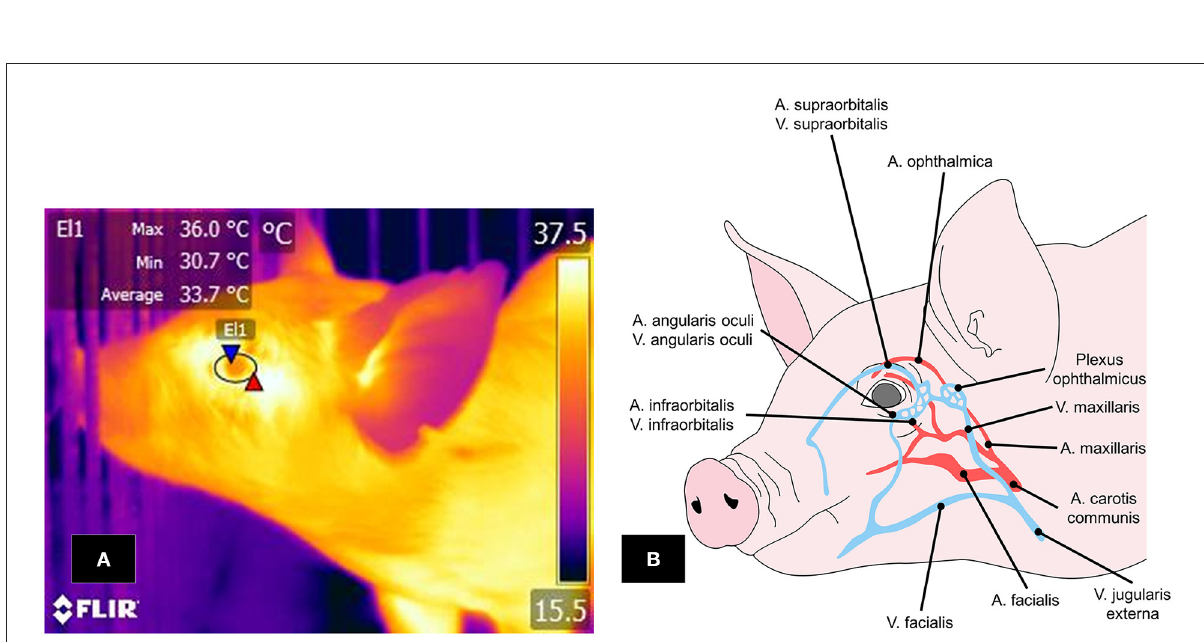
FIGURE5 Ocular window in pigs. (A) The periocular window is outlined by an ellipse (El1) that surrounds the entire ocular surface, including a few millimeters of the upper and lower eyelids. (B) Irrigation to the ocular region, mainly by the supraorbital and infraorbital arteries and veins, which are branches of the maxillary artery and vein. IRT can detect changes in the muscle tone of these vascular structures and the heat radiated through